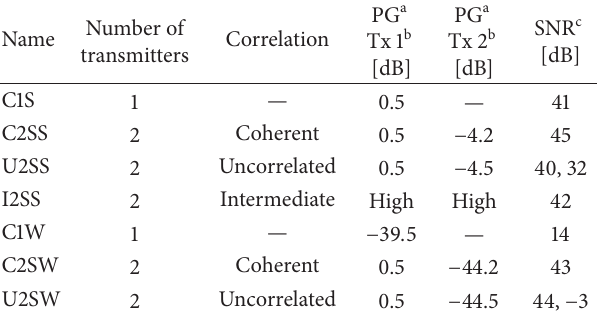
Table 1: Parameters of the measurements.